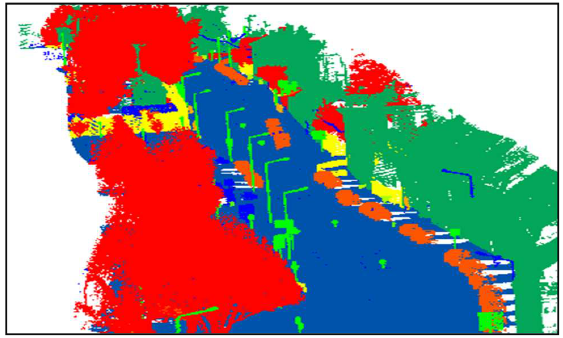
Figure 3 . Paris-Lille-3D dataset